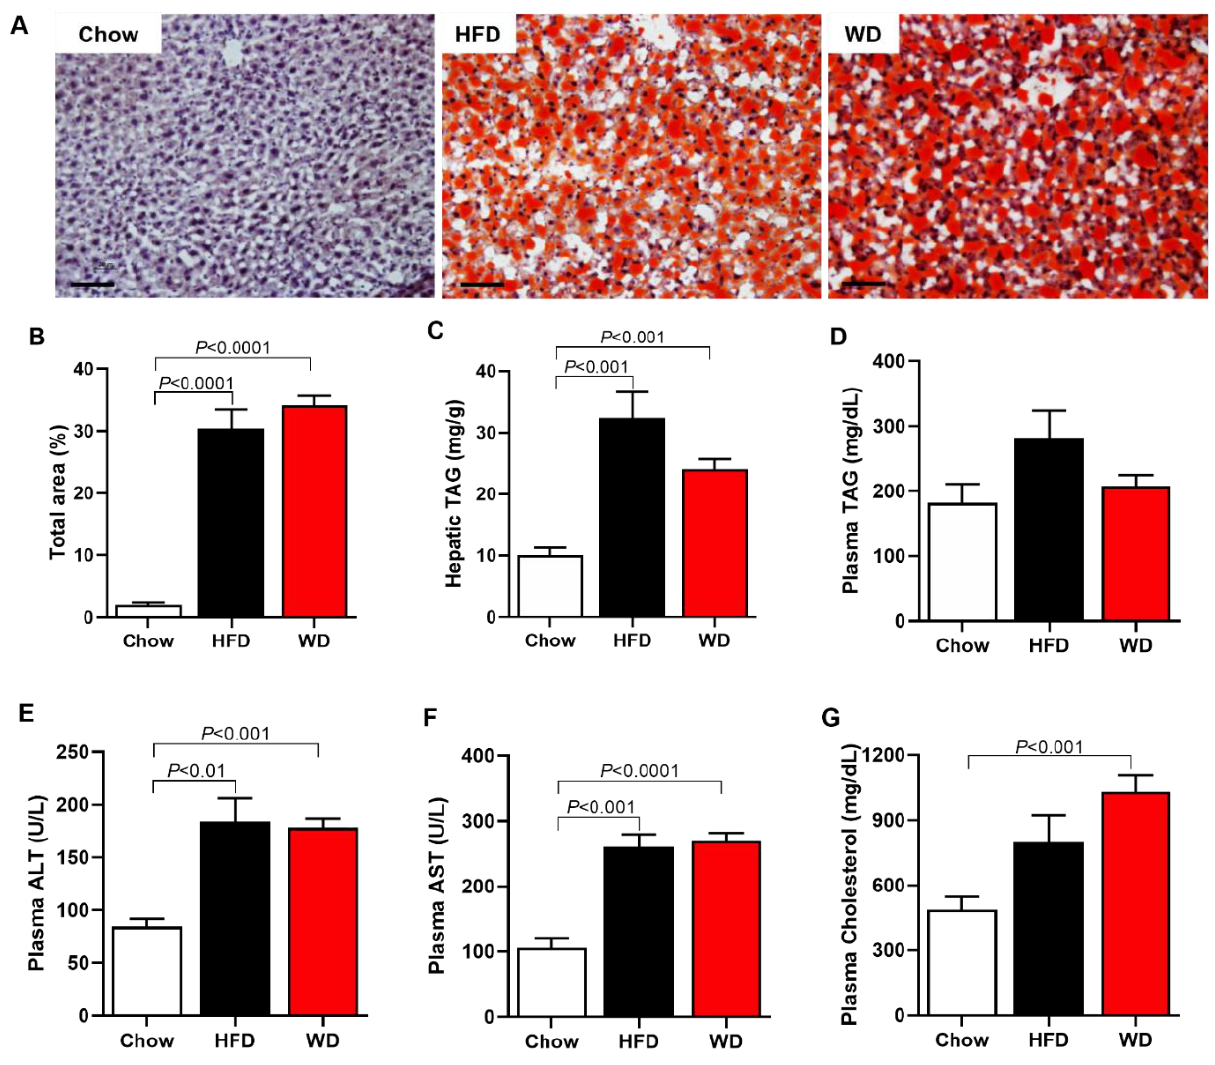
Figure 2. ApoE KO Mice fed an HFD or WD displayed increased liver triglycerides, hepatic enzymes (ALT and AST), plasma cholesterol and lipid droplets. Representative imagens of lipid droplets in the liver, oil red staining (scale of 100 µ m, objective 20 × ) ( A ). Total area of lipid droplet ( B ). Hepatic triglycerides (TAG) ( C ). Plasma triglycerides (TAG) ( D ). Plasma alanine aminotransferase (ALT) ( E ). Plasma aspartate aminotransferase (AST) ( F ). Plasma cholesterol ( G ). Data are represented as mean ± SEM (N = 5–9). The statistical differences as indicated by one-way ANOVA.